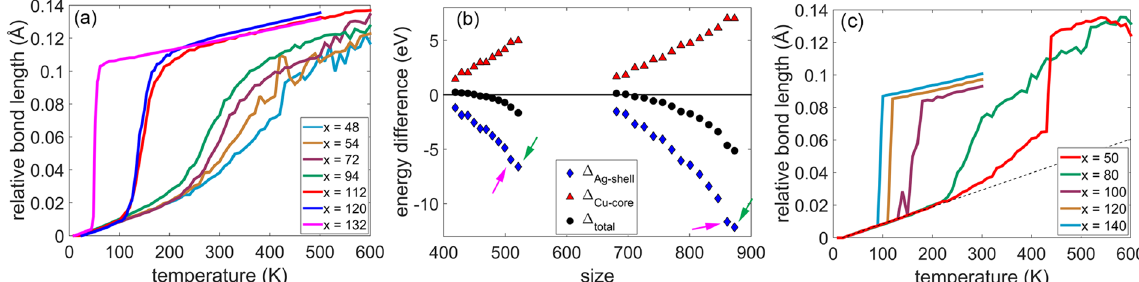
Figure 8. ( a ) Average bond length (relative to the minimum value) of Ag-Ag bonds on shell as a function of temperature in Ag Cu with varying number of Ag atoms ( x in the range 48 - 132). = x 132 represents the x 147 perfect Ag Cu with complete shell. ( b ) Plot of ∆ parameters with progressive removal of {111}-like planes 132 147 on the surface from structure with 12 missing vertices (indicated by magenta arrow). The perfect structures with complete shells are indicated by green arrows for Ag the minimum value) of Ag-Ag bonds on shell as a function of temperature in Ag Ag atoms ( x in the range 50 -